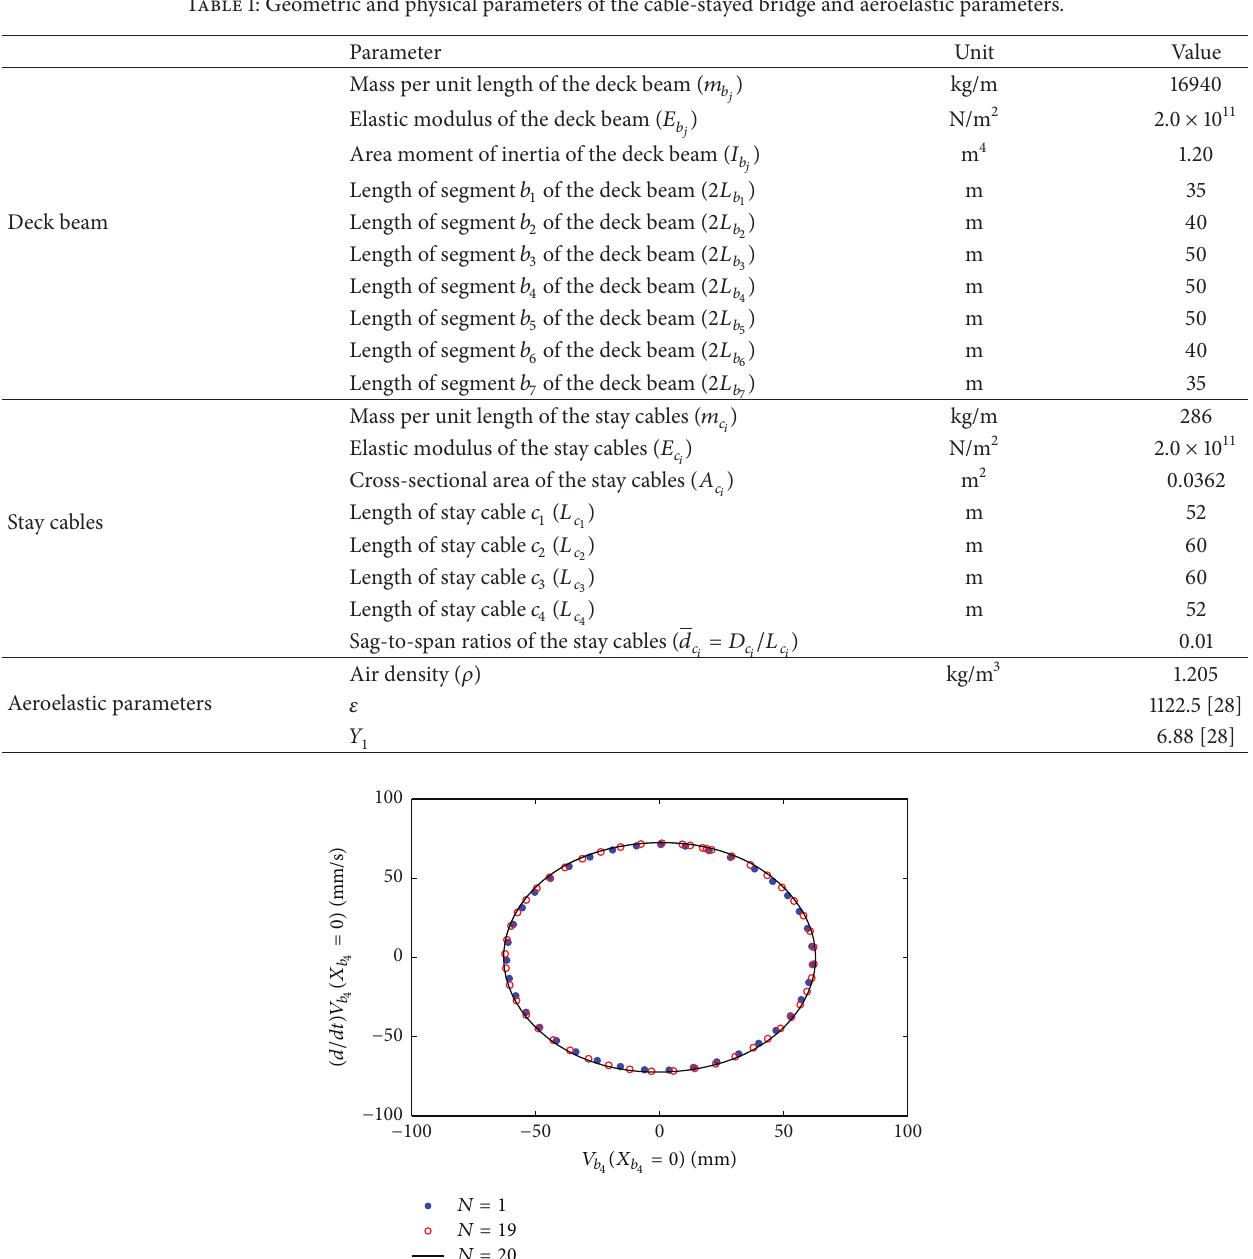
Table 1: Geometric and physical parameters of the cable-stayed bridge and aeroelastic parameters.